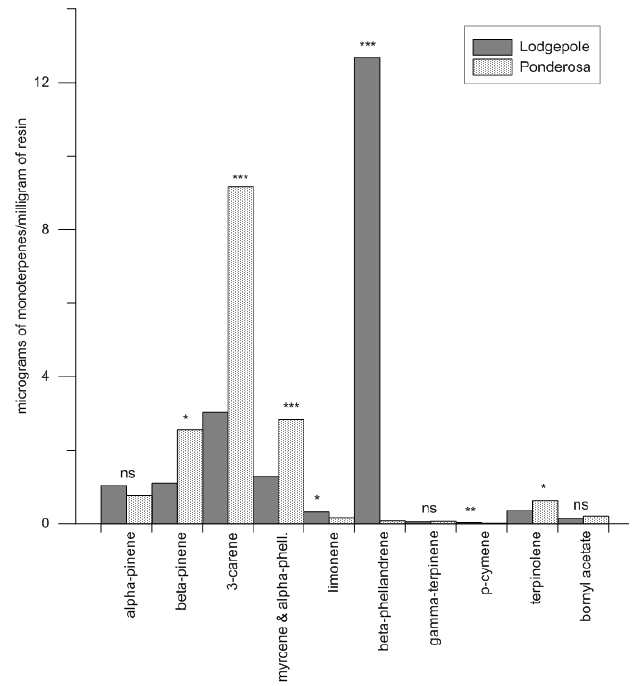
Figure 3. Constitutive oleoresin profile (mean μ g/mg) from Colorado Front Range. Lodgepole pines ( P. contorta var. latifolia ) and ponderosa pines ( P. ponderosa ) derived from gas chromatography coupled with flame ionization detection (GC-FID). Differences between pine species were determined through a MANOVA model (Proc GLM; SAS). Significance: * p < 0.05, ** p < 0.005, *** p < 0.0005; ns: p > 0.05. n =